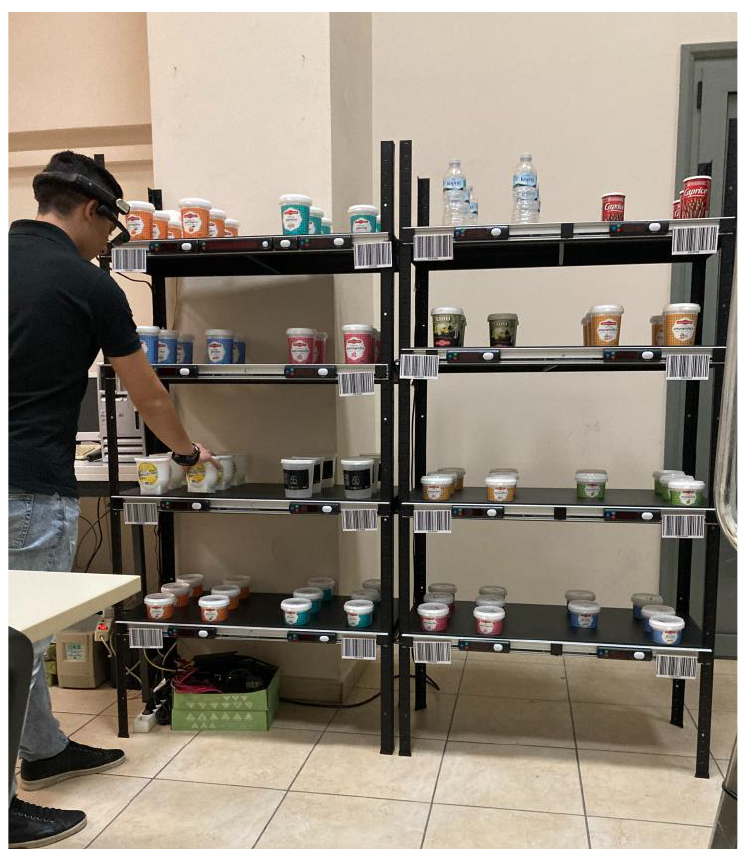
Figure 8. Photo from the execution of laboratory tests.